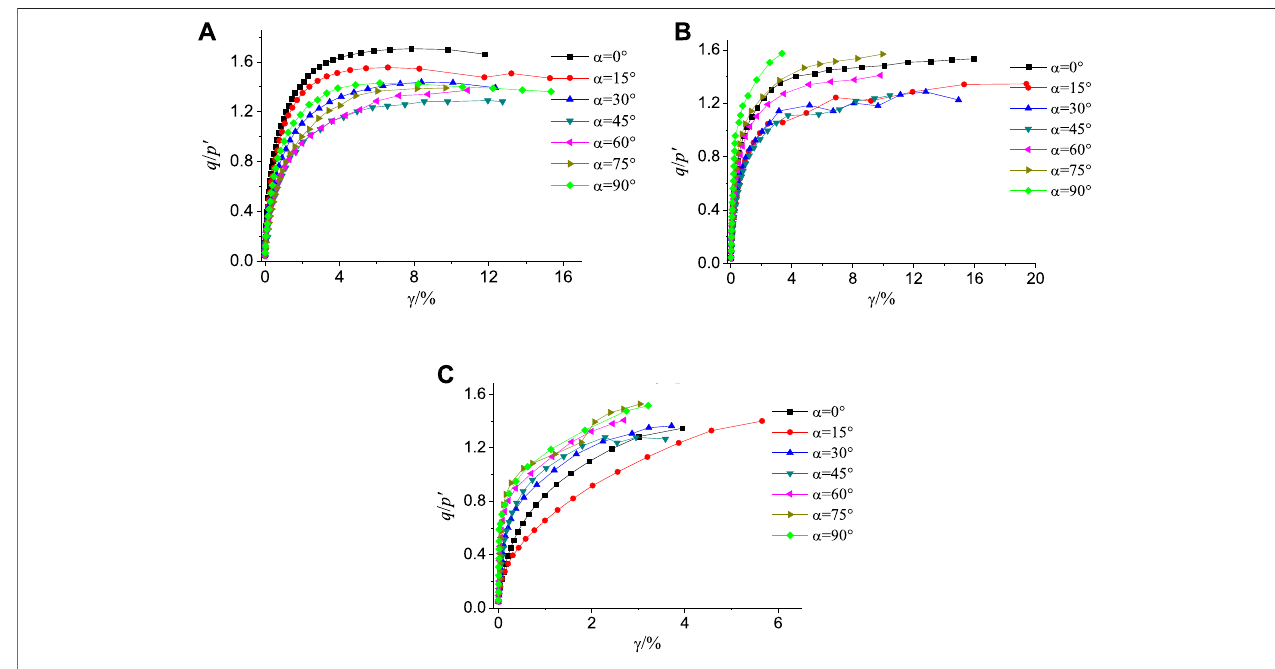
FIGURE 5 | Curves of generalized shear stress ratio-strain diagram at different principal stress direction angles: (A) b = 0; (B) b = 0.5; (C) b = 1